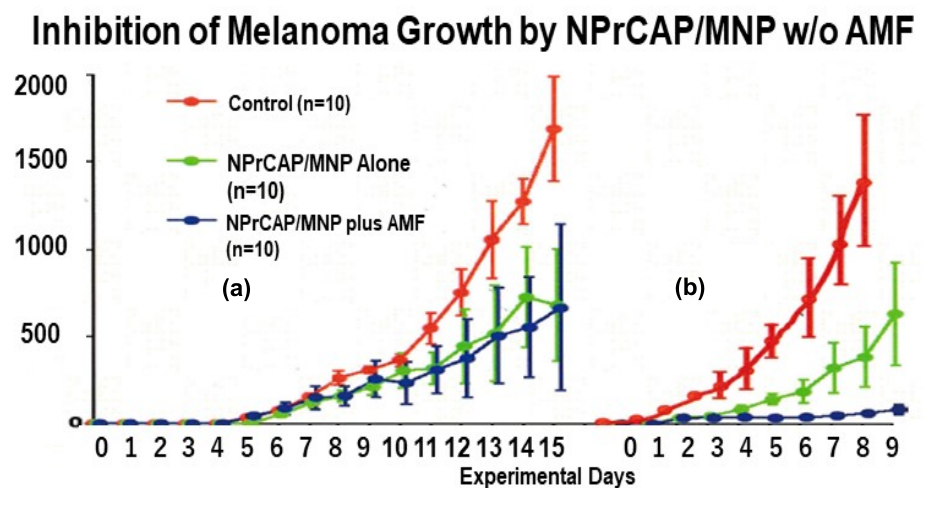
Figure 12. Melanoma growth inhibition by NPrCAP/MNP with/without AMF. ( a ) Growth of primary melanoma transplants in mice. ( b ) Growth of second re-challenge melanoma tumors transplanted on the flank opposite from the primary tumor on day 53, 40 days after excision of the primary tumors.